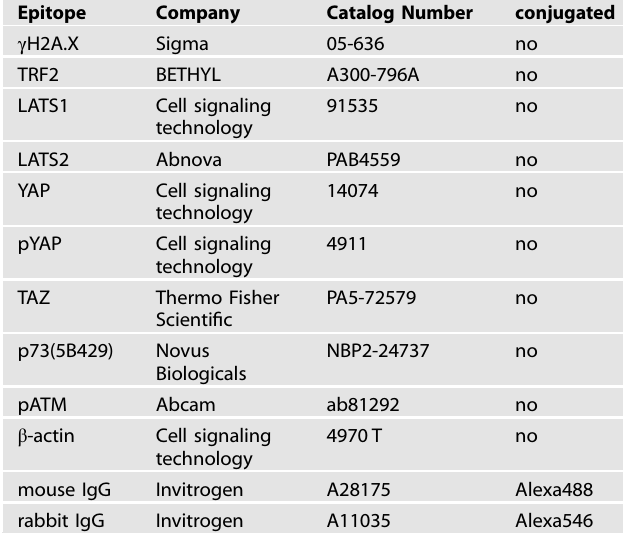
RPN2124) following the manufacturer ’ s protocol. The antibodies used are listed in Table 3. Crystal structure and 3D models of protein The human SMG6 PIN domain structure was generated using PyMOL (PDB accession number: 2HWW).